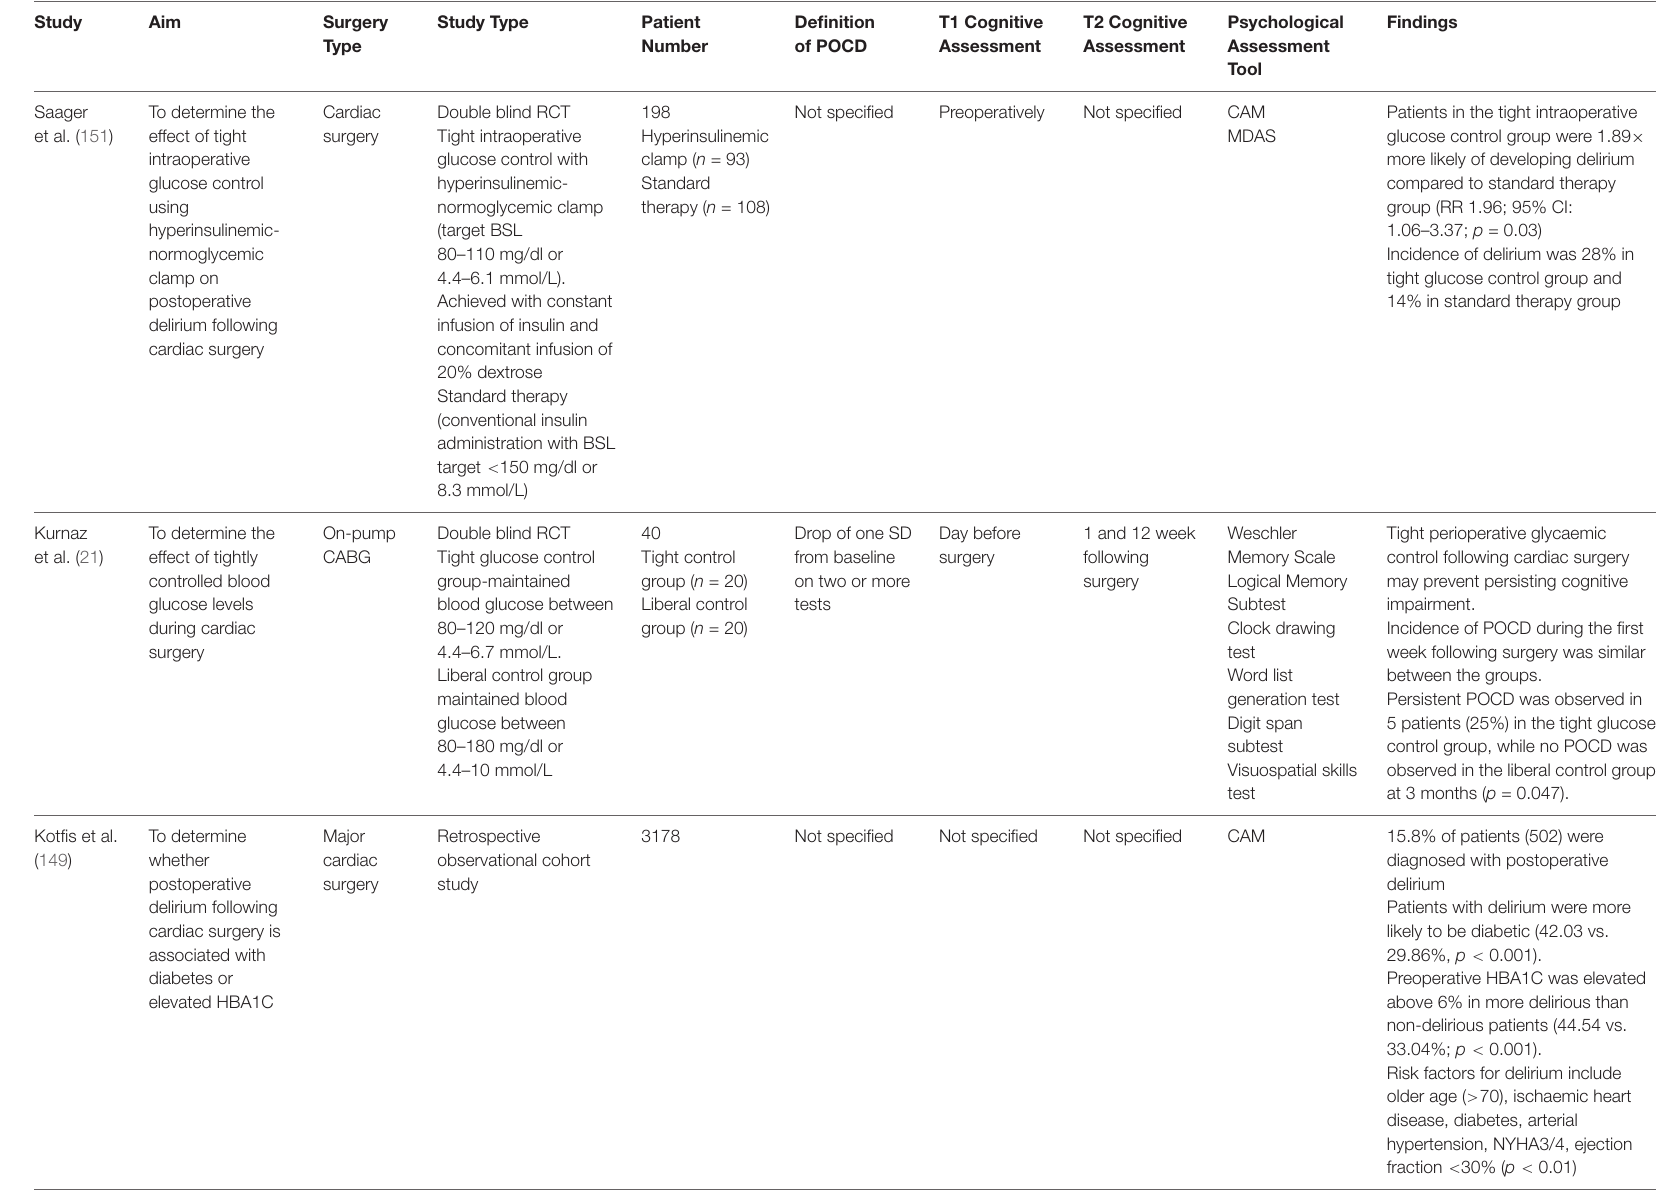
TABLE 6 | Studies assessing the effect of glycaemic control on post-operative cognitive impairment following cardiac